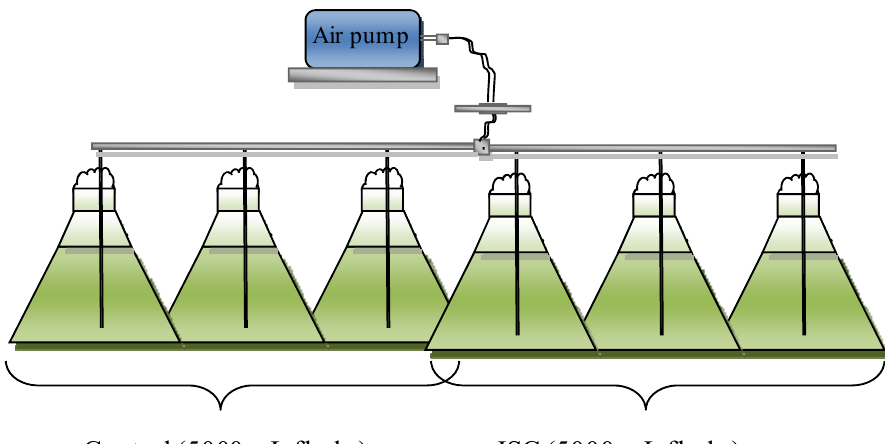
Figure 1. Schematic diagram for the growing for biodiesel